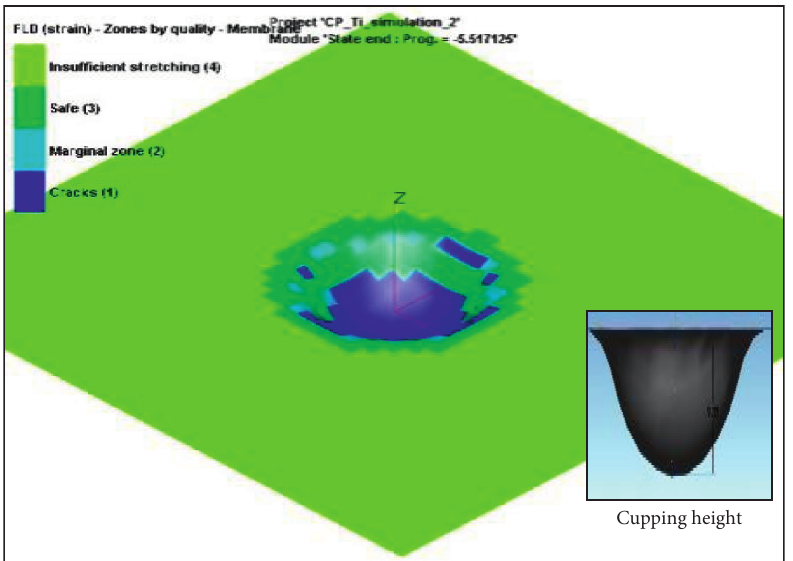
Figure 8: Simulated results indicating the FLD strain zones recorded after ball-punch